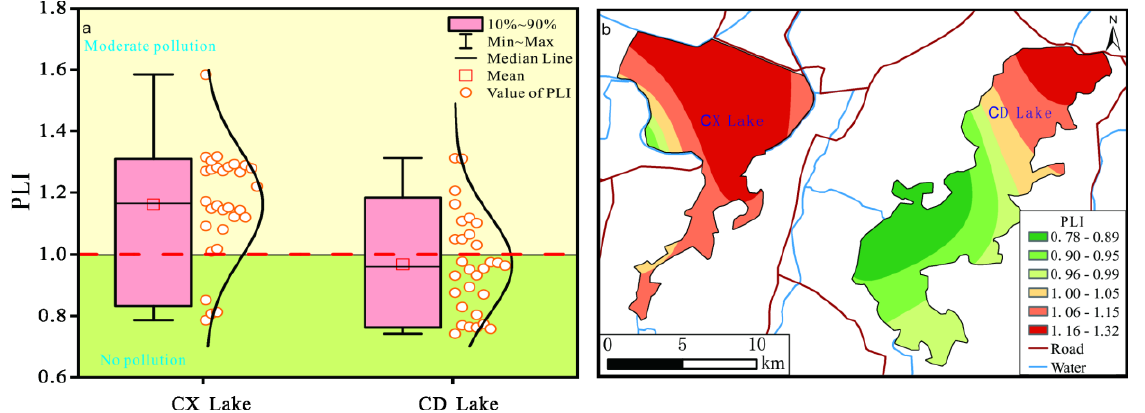
Figure 4. Boxplot ( a ) and spatial distribution ( b ) of PLI of heavy-metal elements in sediment. This Figure 4. Boxplot (a) and spatial distribution (b) of PLI of sediment heavy metal elements. This 325 figure was drawn with Origin 2017 software. Figure was drawn with Origin 2017 software. 326